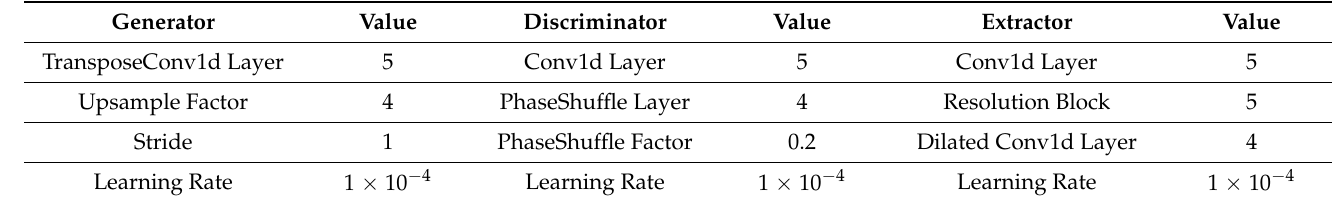
Table 3. Parameter